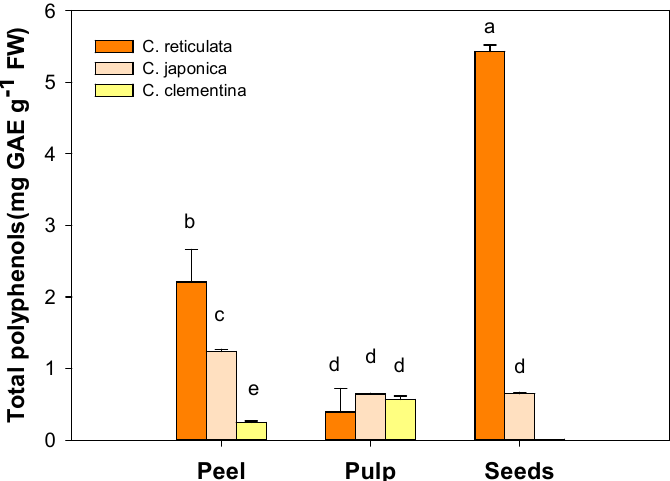
Figure 1. Total polyphenols in peel, pulp and seeds of the three di ff erent mandarin cultivars: C. reticulata (Phlegrean mandarin), C. japonica (Kumquat) and C. clementina (Clementine). Each bar represents the mean ± SE ( n = 6). Di ff erent letters indicate statistically significant di ff erences among mandarin varieties ( p < 0.05). Results were analysed by one-way ANOVA followed by Holm–Sidak post hoc test for multiple comparisons. GAE: gallic acid equivalents; FW: fresh weight.